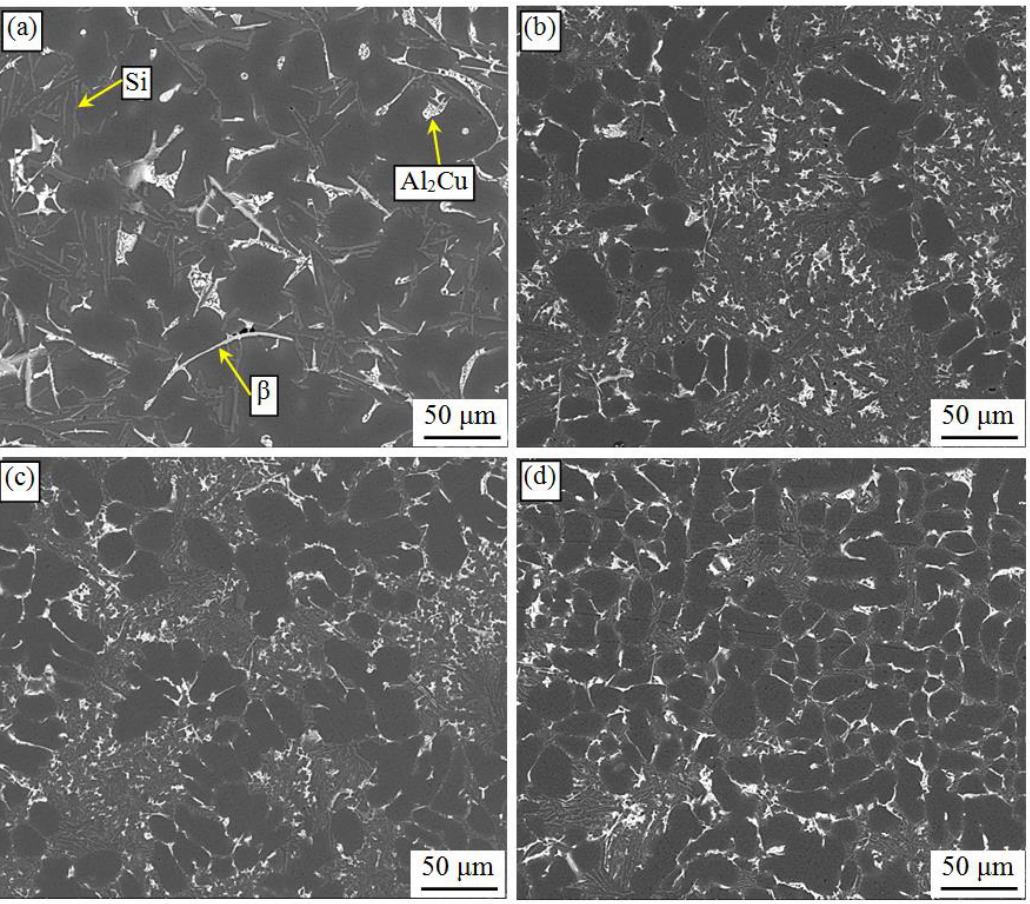
Figure 12. SEM micrographs of as-cast HPRSC A1 alloy treated by UV-ES compound field (β stands for β-Al 5 FeSi): ( a ) 0 MPa; ( b ) 100 MPa; ( c ) 200 MPa; ( d ) 400 MPa.